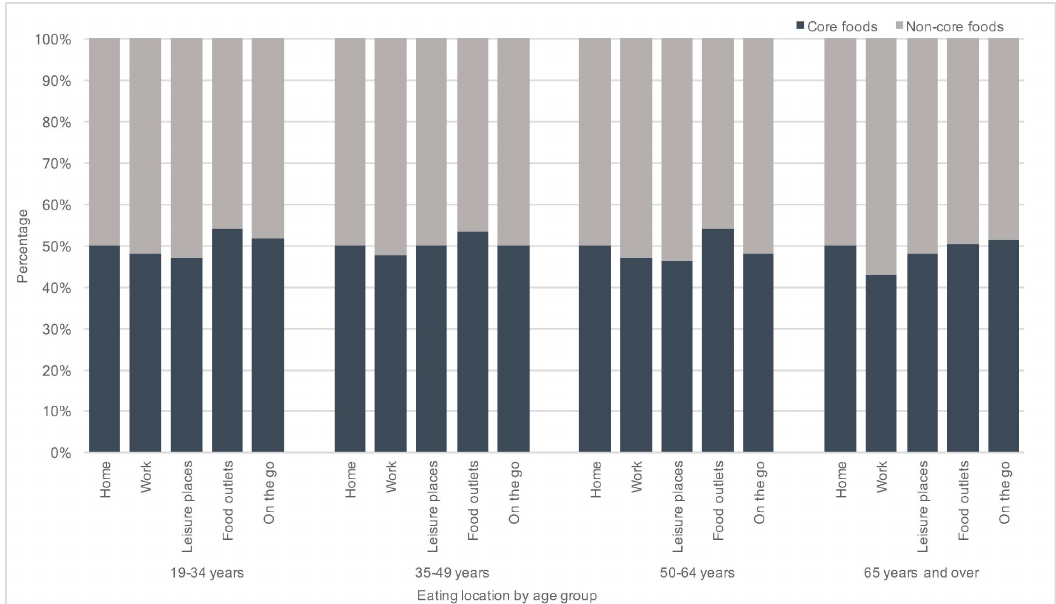
Figure 2. Percentage consumption of core and non-core foods by reported eating location for the NDNS RP Years 1–6 (2008–2014) adult